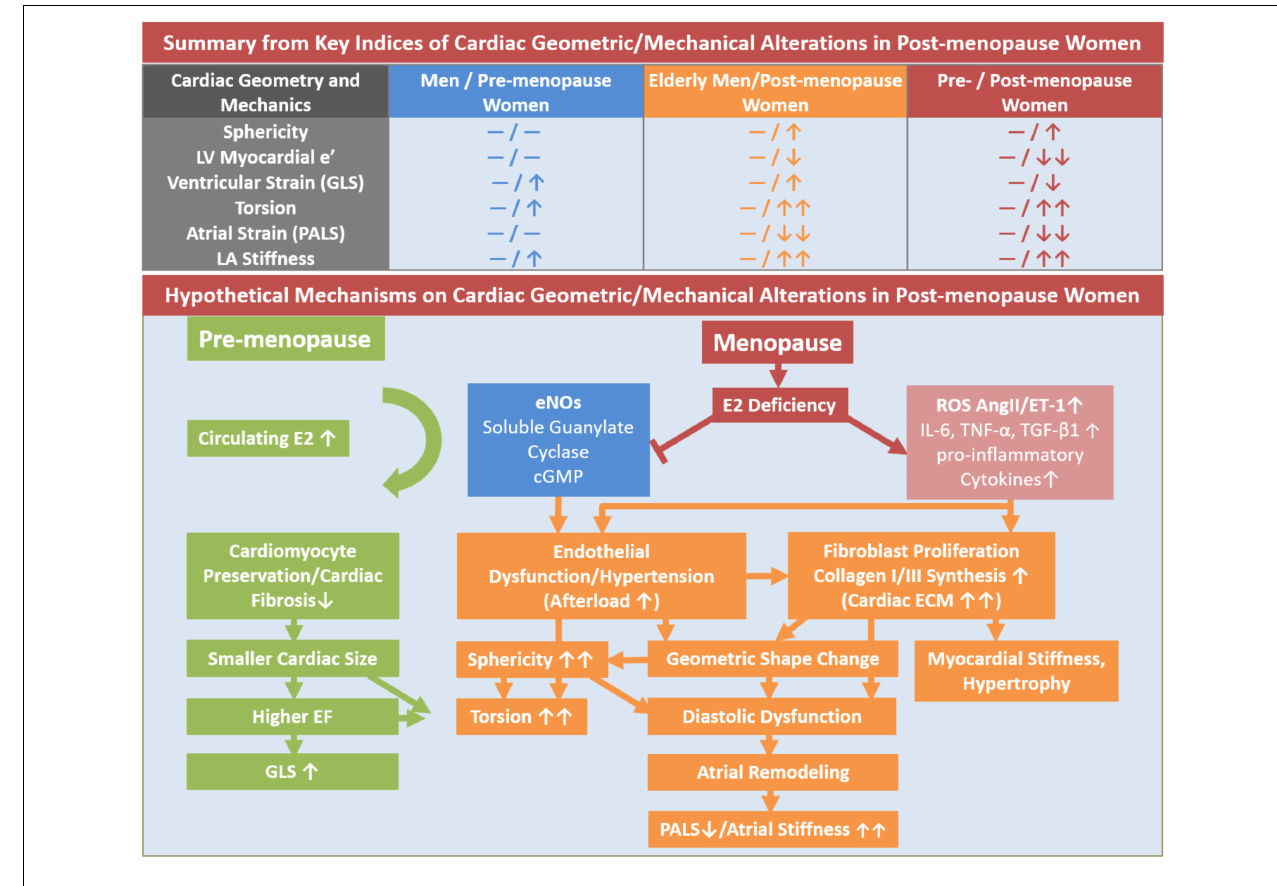
FIGURE 4 | Illustrative summary of hypothetical mechanisms of LV geometric and mechanical alterations in post-menopausal women in contrast to men and pre-menopausal women. cGMP, cyclic GMP; eNOS, endothelial nitric oxide synthase; GLS, global longitudinal strain; IL-6, cytokine interleukin-6; PALS, peak atrial longitudinal strain; TGF- β , transforming growth factor; TNF, tumor necrosis